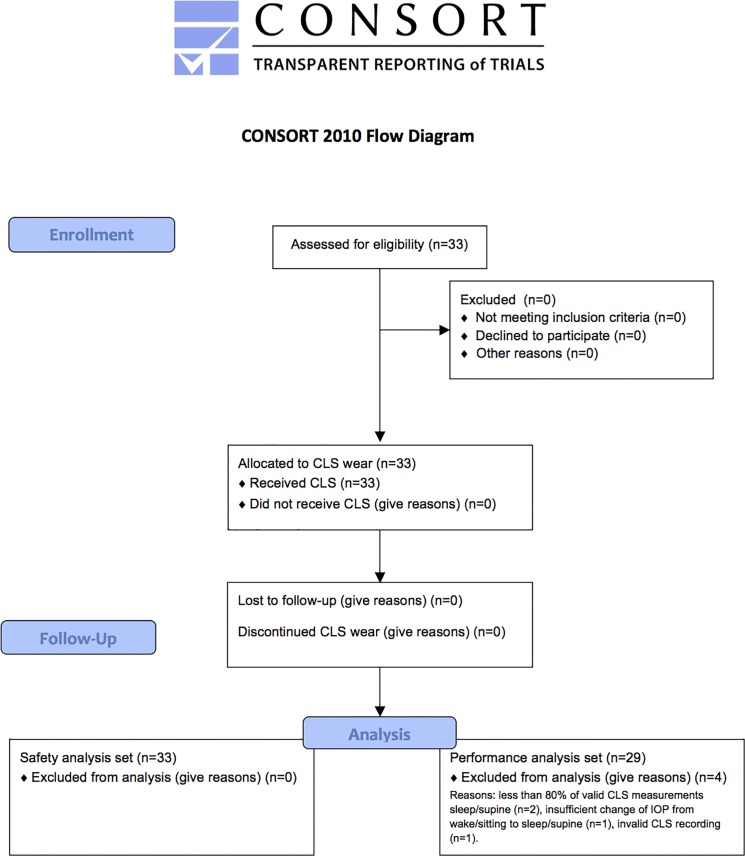
CONSORT flow chart.